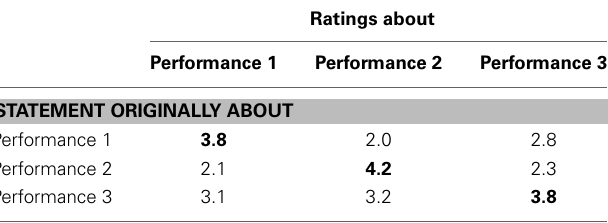
Table 2 | Average endorsement (both players) for generalizable statements.